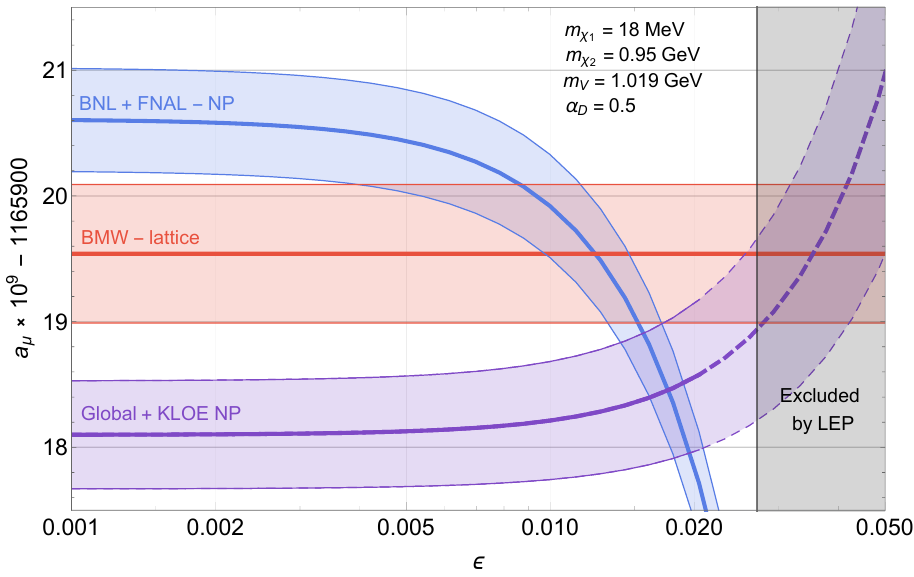
Figure 6 . Theoretical prediction (purple) for a µ as a function of ε for a dark photon model with m = 18 MeV, m = 0 . 9 GeV, m = 1 . 019 GeV and α = 0 . 5 . The dashed purple curve χ 1 χ 2 V D denotes the region where the KLOE08 and KLOE10 results are more than 3 σ away. The blue band corresponds to the combined BNL and FNAL experimental results after subtracting the direct NP contribution from the dark photon. The red band shows the prediction obtained with the BMW lattice estimate of a LO , HVP . The width of the bands represents 1 σ uncertainties. The grey region is µ excluded by